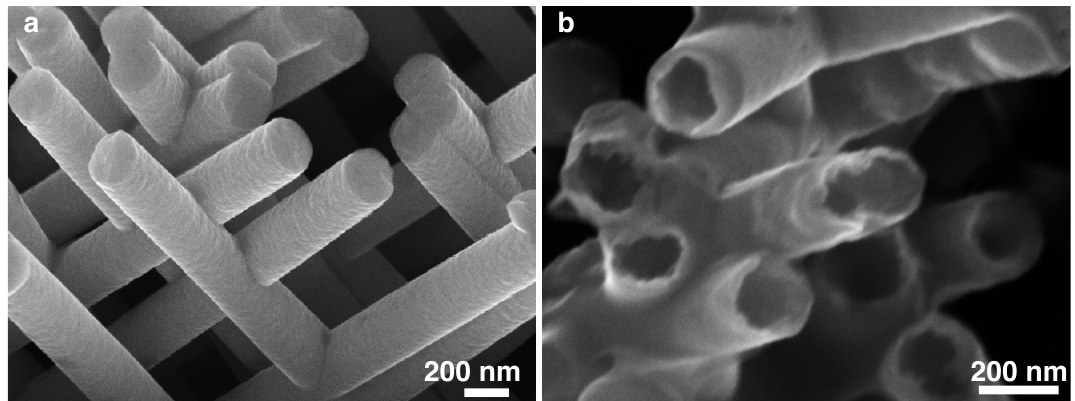
Figure 2. SEM images of ( a ) a Ni crossed nanowire and ( b ) a Ni crossed nanotube networks with 230 nm diameter and 20% of packing fraction, both electrodeposited at a potential of − 1 V. The images have been obtained after the complete removal of the polymer host template and testify of the nanowire and nanotube